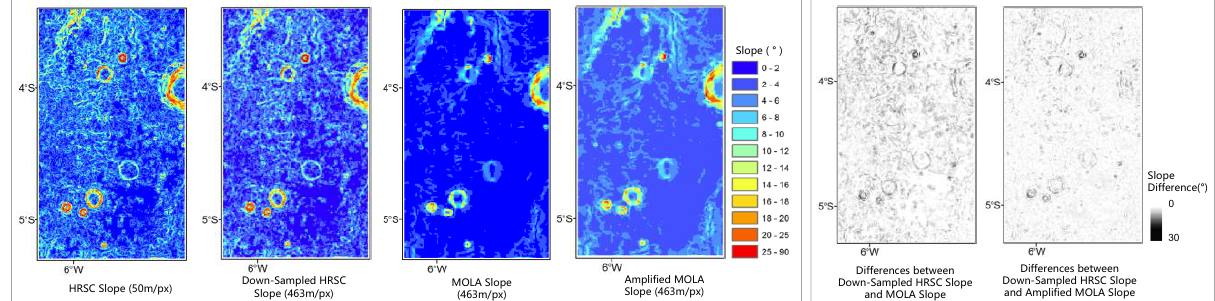
Figure 9. Verifications between HRSC data and MOLA data